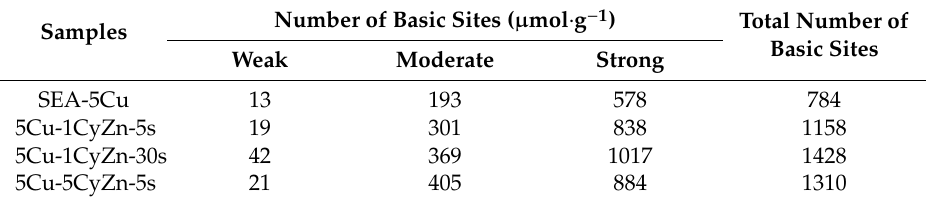
Table 4. Basic properties of the SEA-5Cu and ZnO over-coated Cu / SiO 2 catalysts.